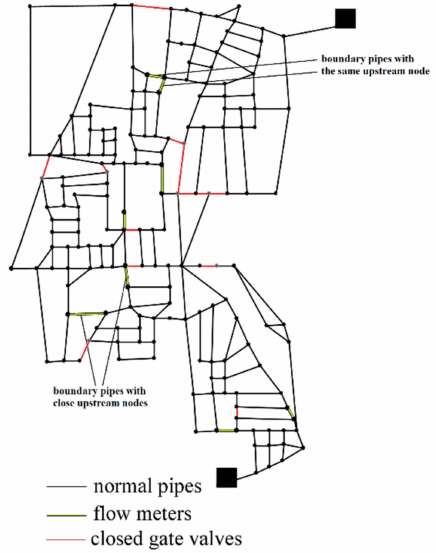
Figure 2. WDN partitioning into 5 DMAs.